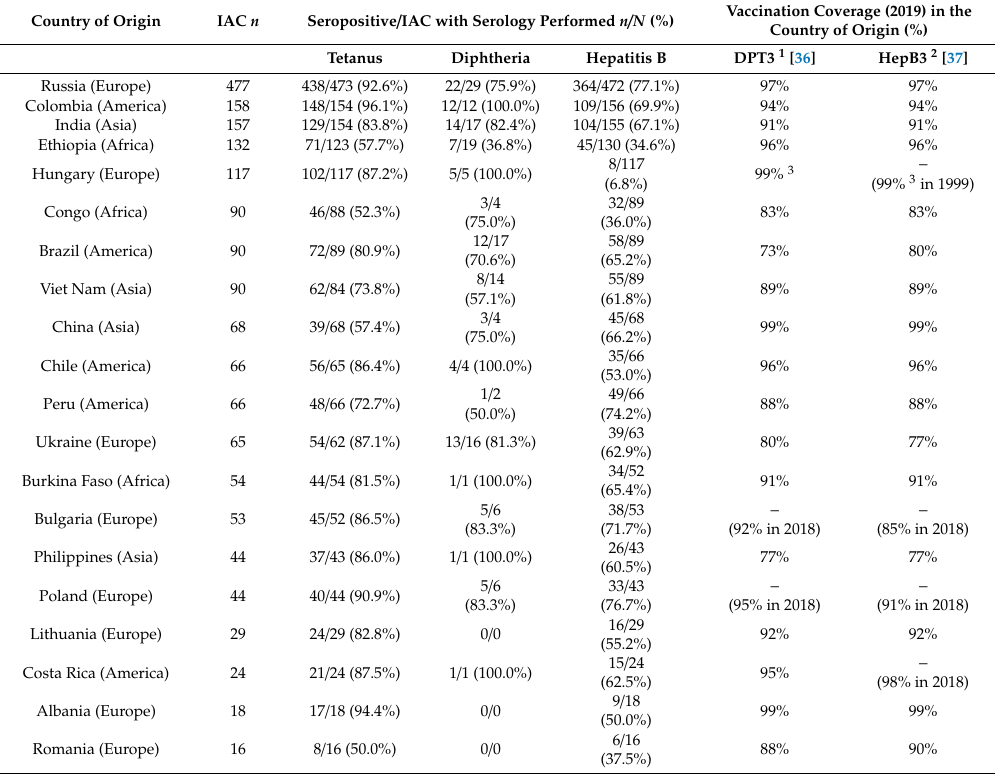
Table 4. Seropositive IAC for tetanus, diphtheria, and hepatitis B among those with serology performed compared to vaccination coverage in 2019, by country of origin.